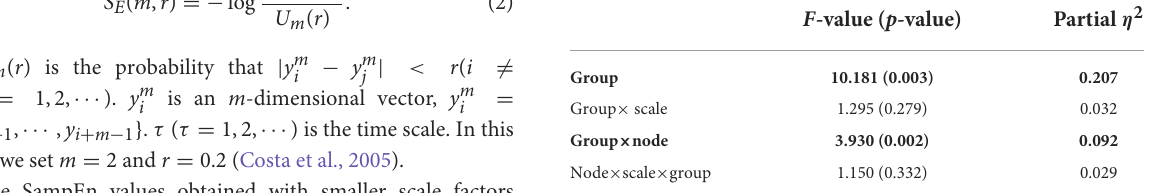
TABLE 2 High cognitive function group vs. low cognitive function group based on the repeated measure ANCOVA results F -value ( p -value) and partial η 2 -value in multi scale entropy (MSE) analysis results, F and p -value with p < 0.05 are indicated by bold